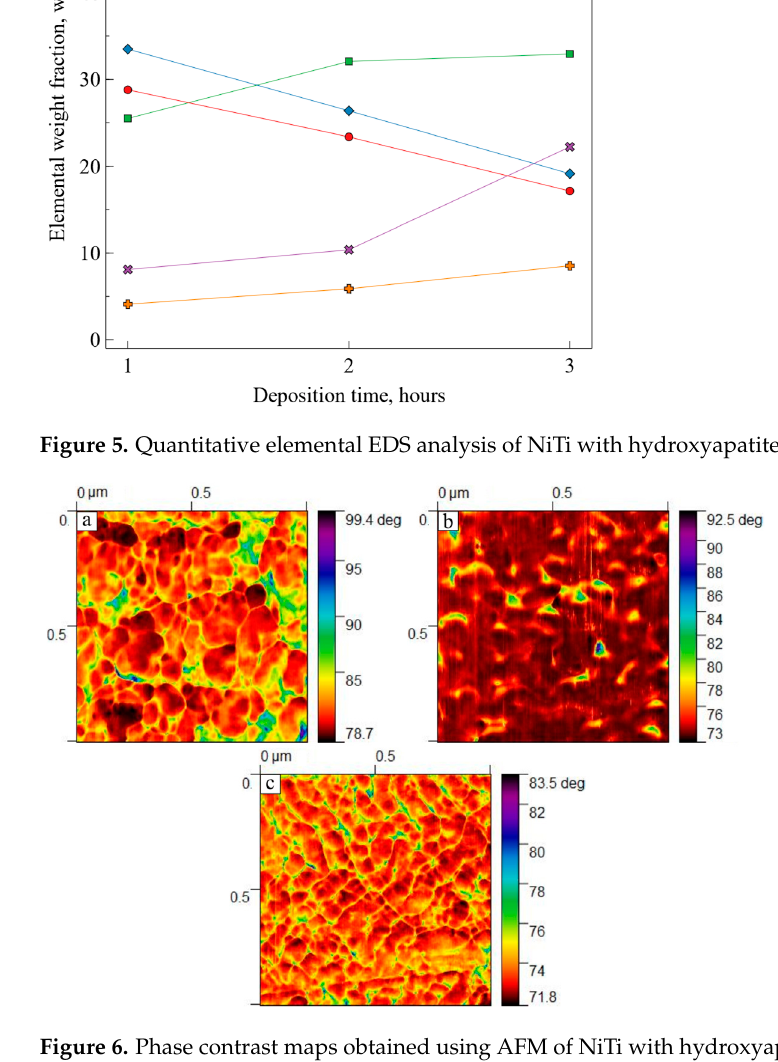
Figure 6. Phase contrast maps obtained using AFM of NiTi with hydroxyapatite coatings deposited for: ( a ) 1 h; ( b ) 2 h; and ( c ) 3 h.